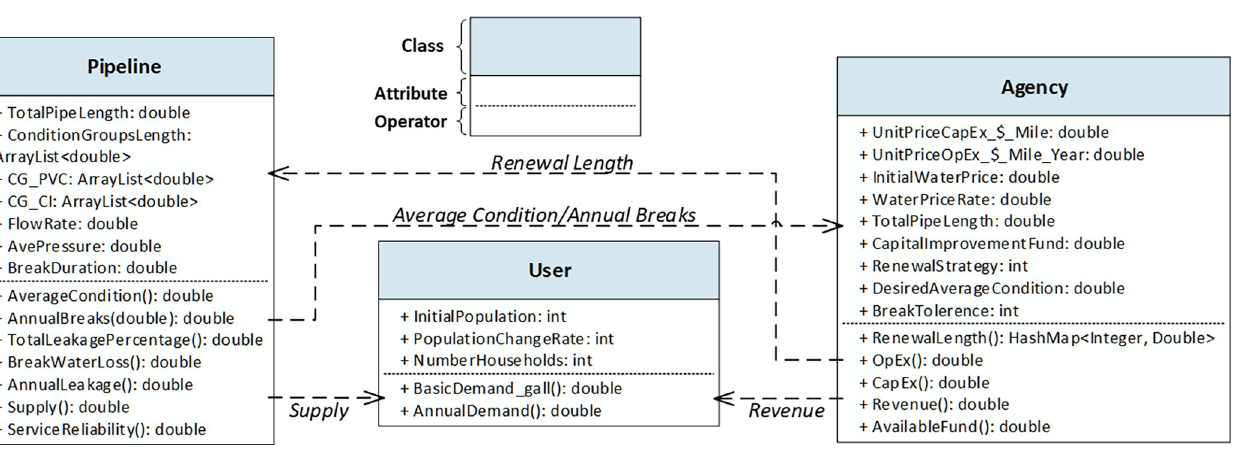
Fig 4. Unified Modeling Language (UML) class diagram of the